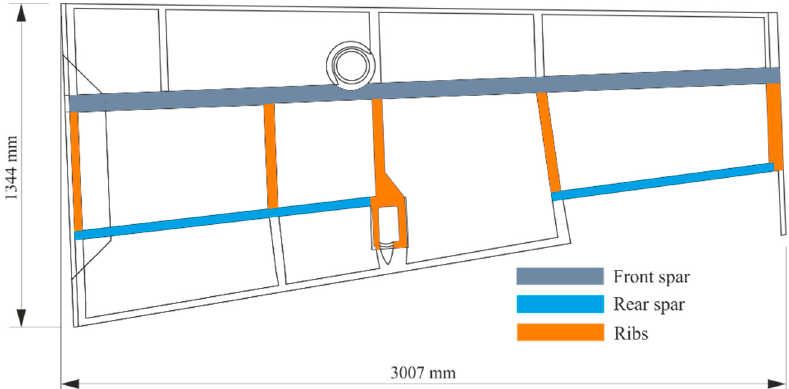
Figure 1. Composite wing configuration with the area of interest.